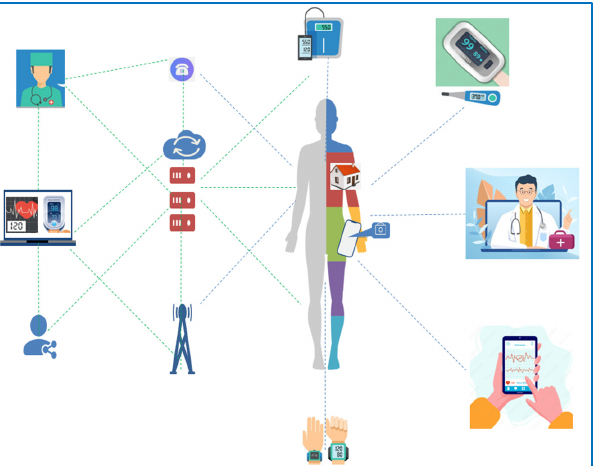
Figure 1. The telemedicine ecosystem.